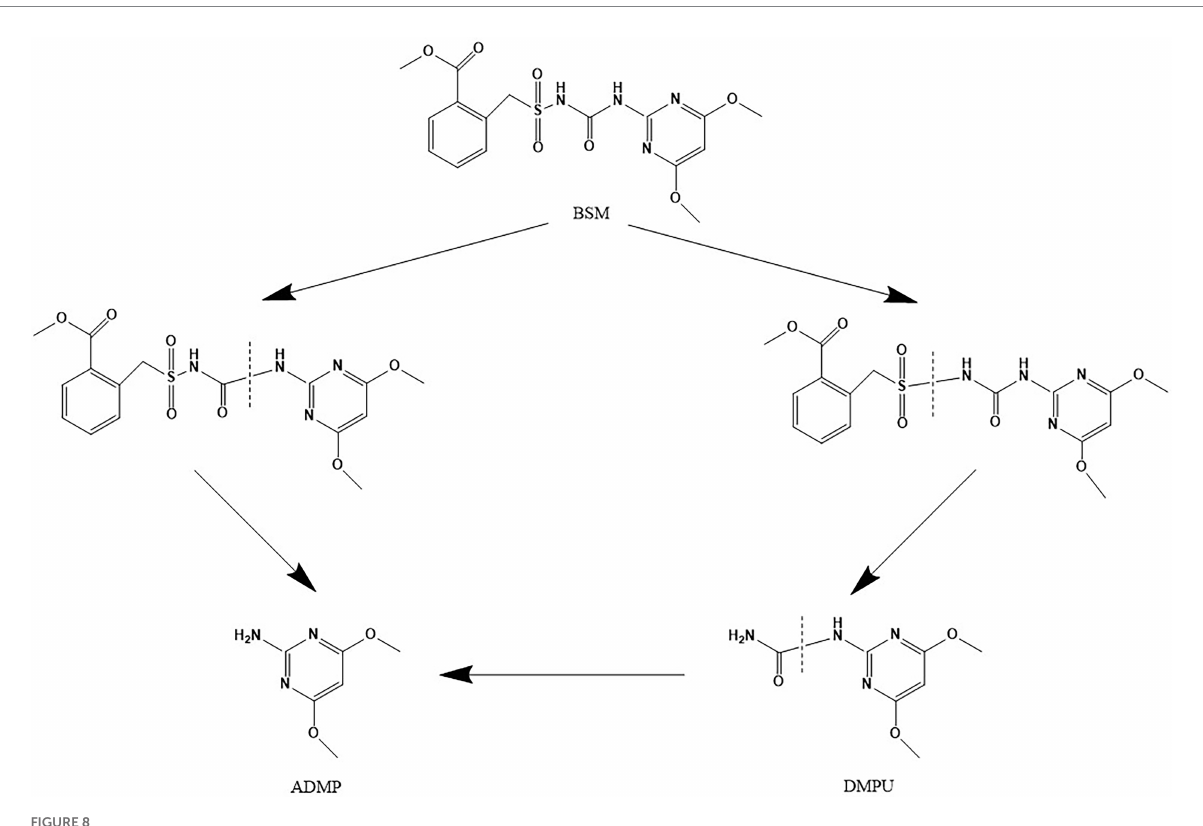
FIGURE 8 Proposed pathways for the degradation of BSM by strain CD3.